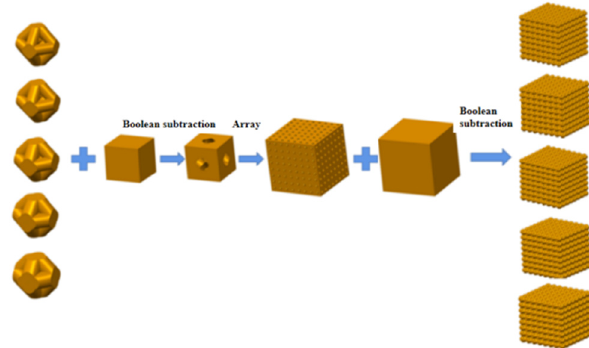
Figure 2: Modeling process of